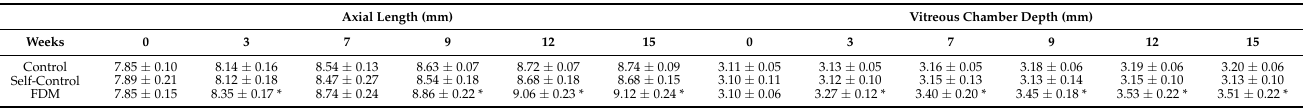
eyes and control eyes. The axial length, VCD, refractive error and corneal curvature in the self-controls and naïve nontreated controls were comparable (Tables 1 and 2). Table 1. The change of axial length, vitreous chamber depth in different groups during the course of the study ( n = 12/group).